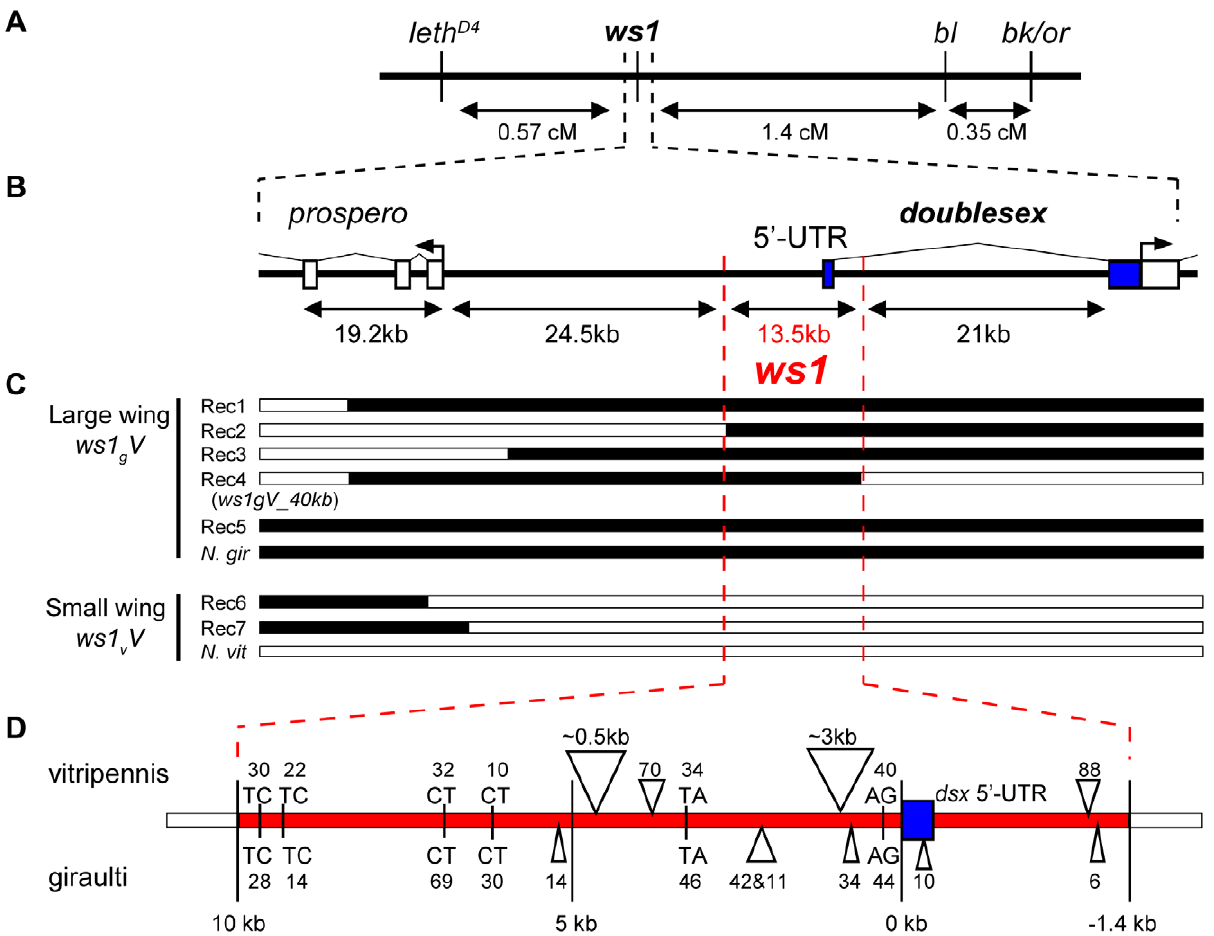
Figure 3. Positional cloning: ws1 maps to the doublesex locus. (A) Recombination map of ws1 and flanking phenotypic markers used for positional cloning. (B) Genome map of the region around ws1 including gene annotations. (C) Genotype and phenotype of recombinants near ws1 . Black: N. giraulti, White: N. vitripennis . (D) Map of sequence features in the 13.5kb ws1 locus. Triangles: Insertions, with size given in base pairs (bp). Letters: Microsatellite repeats, with size given in bp. Blue: dsx 5 9 -UTR.